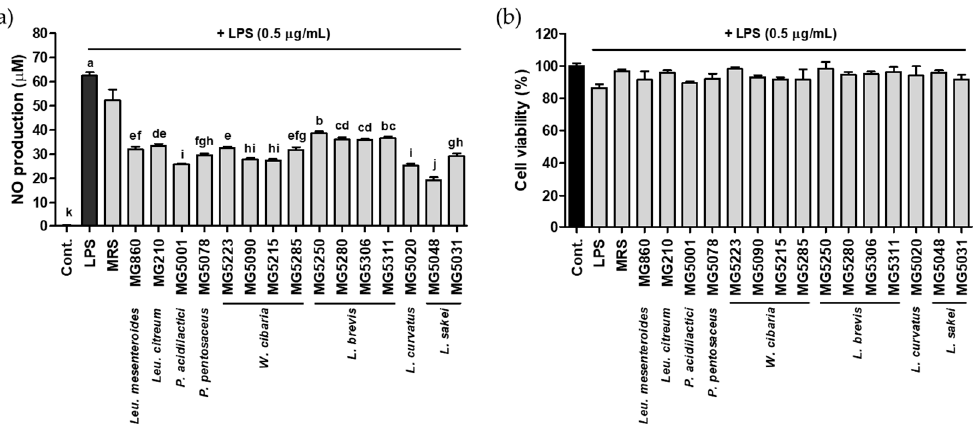
Figure 1. Effect of CFS from 15 bacterial strains on ( a ) NO production and ( b ) cytotoxicity in LPS- activated RAW264.7. Data are represented as mean ± SD and bar with different letters indicating significance at p <